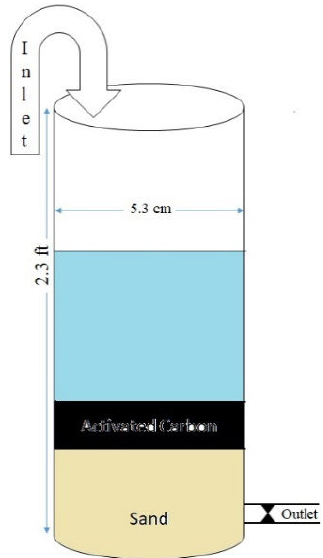
Fig. 2. Schematic of filter